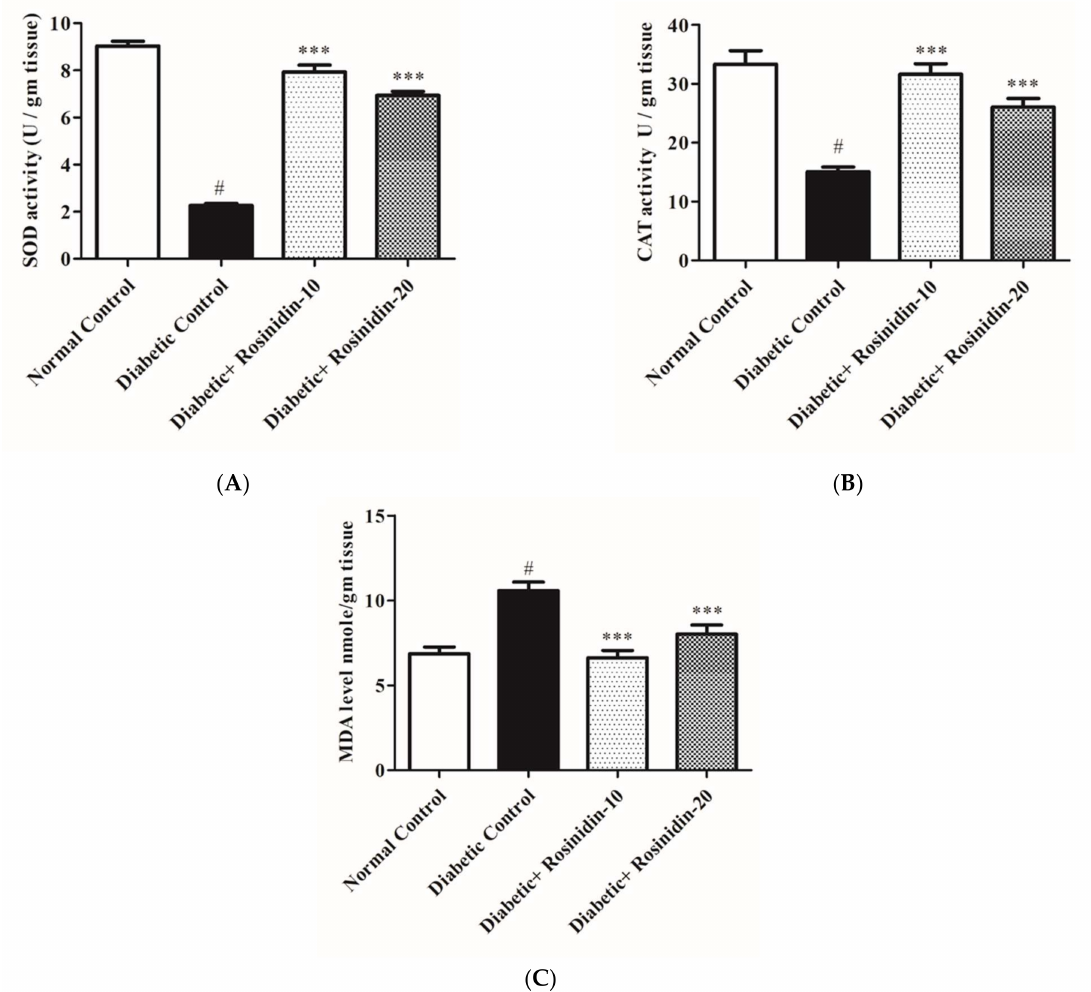
Figure 9. ( A ) Effect of rosinidin on SOD against that of STZ-induced diabetic rats ( n = 6). Values are expressed as mean ± SEM. # p < 0.05, normal control vs. diabetic control; *** p < 0.001, diabetic control vs. rosinidin-10, rosinidin-20. ( B ) Effect of rosinidin on CAT against that of STZ-induced diabetic rats ( n = 6). Values are expressed as mean ± SEM. # p < 0.05, normal control vs. diabetic control; *** p < 0.001, diabetic control vs. rosinidin-10, rosinidin-20. ( C ) Effect of rosinidin on MDA against that of STZ-induced diabetic rats ( n = 6). Values are expressed as mean ± SEM. # p < 0.05, normal control vs. diabetic control; *** p < 0.001, diabetic control vs. rosinidin-10,